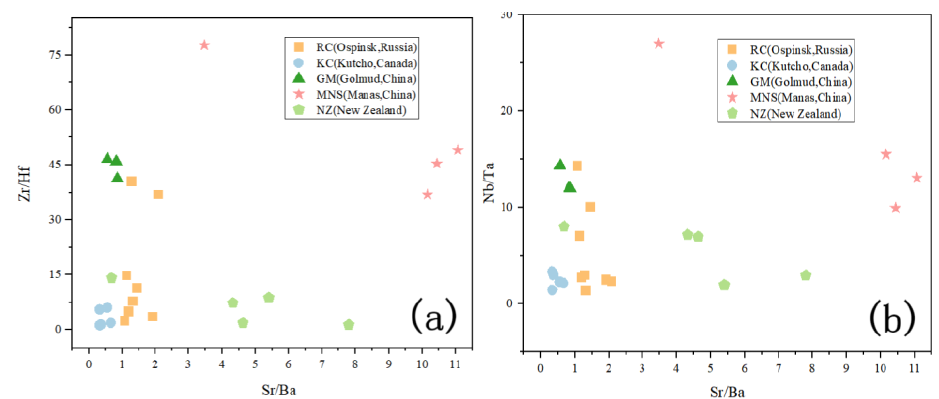
Figure 13. ( a ) Characteristics of Zr/HF and Sr/Ba ratios of green nephrite from different areas. ( b ) Characteristics of Nb/Ta and Sr/Ba ratios of green nephrite from different areas.